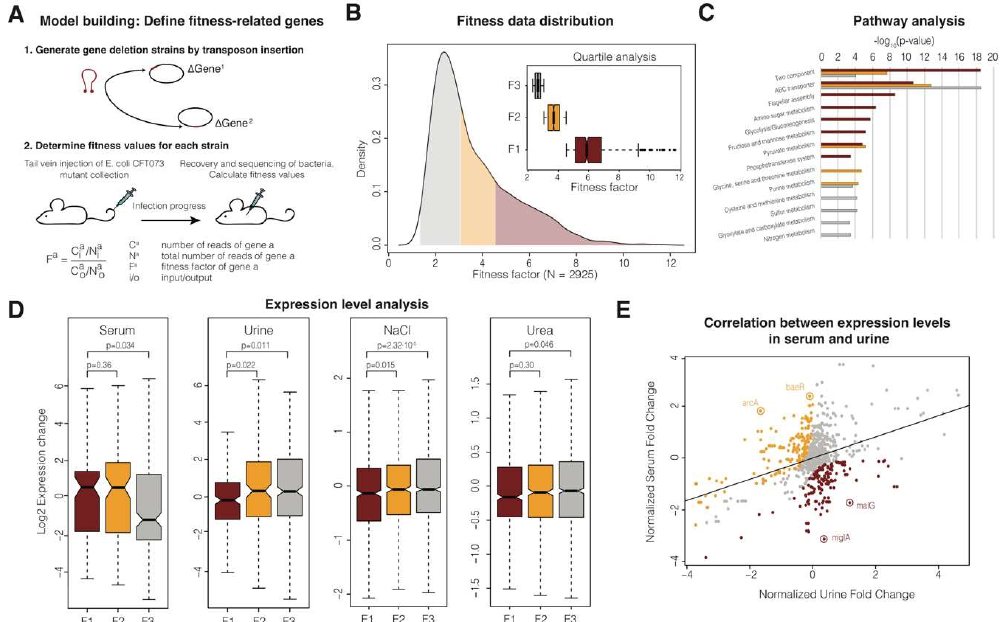
Figure 1. Schematics of the experimental design, fitness definition and gene expression analysis. ( A ) To determine the fitness of each gene in the E. coli CFT073 genome, transposons are inserted at random in the genome, generating a pool of mutants that can be characterized by sequencing. To determine the contribution of each gene to the fitness of the organism, this mutant pool can be injected in mice and any remaining bacteria recovered and sequenced after infection. Those mutants unable to infect the host will be depleted from the output pool compared to the input pool (fitness values > 1). ( B ) Density plot showing the distribution of the calculated fitness values. Genes were classified according to quartiles; F1 genes correspond to the first quartile (dark red), F2 genes to the third quartile (orange) and grey genes to both the first and second quartiles (grey). The distribution of fitness values for each gene group is depicted as a boxplot in the insert. ( C ) Pathway analysis enrichment for each gene group. p -values are represented for each group and pathway (only significant pathways with an adjusted p -value < 0.05 using the Benjamini-Hochberg correction are shown in the figure). ( D ) Expression levels for genes in four di ff erent conditions: serum, urine, sodium chloride (NaCl) and urea. Statistical analyses were performed using the Mann-Whitney U-test and p -values corresponding to all the comparisons are shown in the figure. The median value for each group of proteins is shown with a horizontal black line. Boxes represent values between the first and third quartiles. All the values outside this range are considered to be outliers and were removed to improve visualization. The notches correspond to a ~95% confidence interval for the median. ( E ) Correlation of gene expression levels between serum and urine. Expression levels were first normalized using z-scores. Di ff erentially expressed genes between serum and urine are highlighted in orange ( > two-fold rank increase in serum compared to urine) and red ( > two-fold rank increase in urine compared to serum). Some exemplars in both sets are highlighted in the